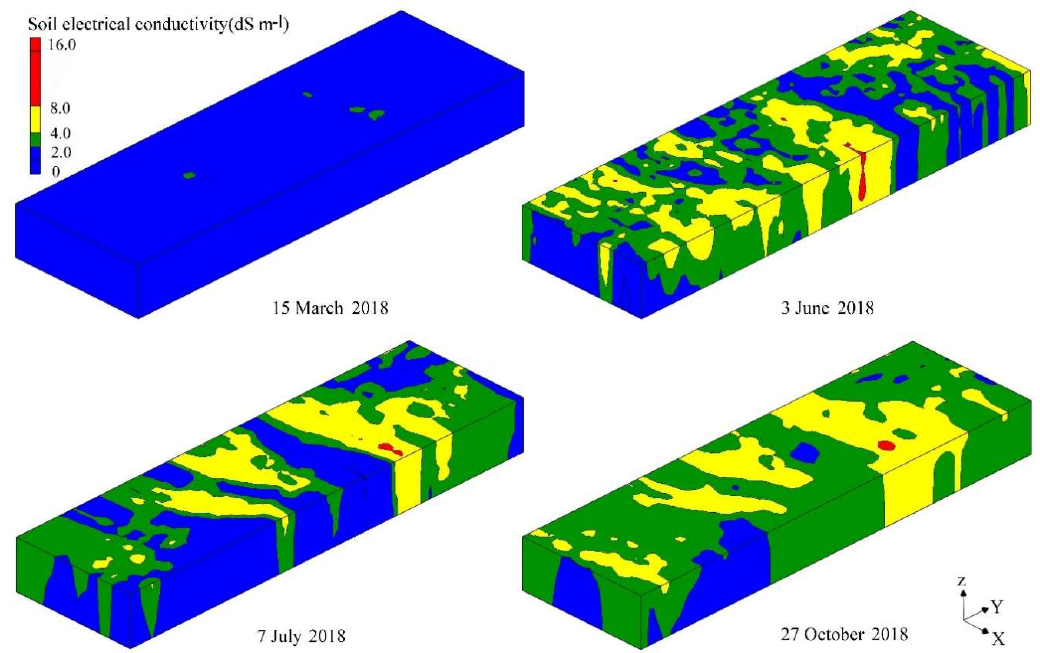
Figure 3. Three-dimensional distribution of soil salinity in different periods.